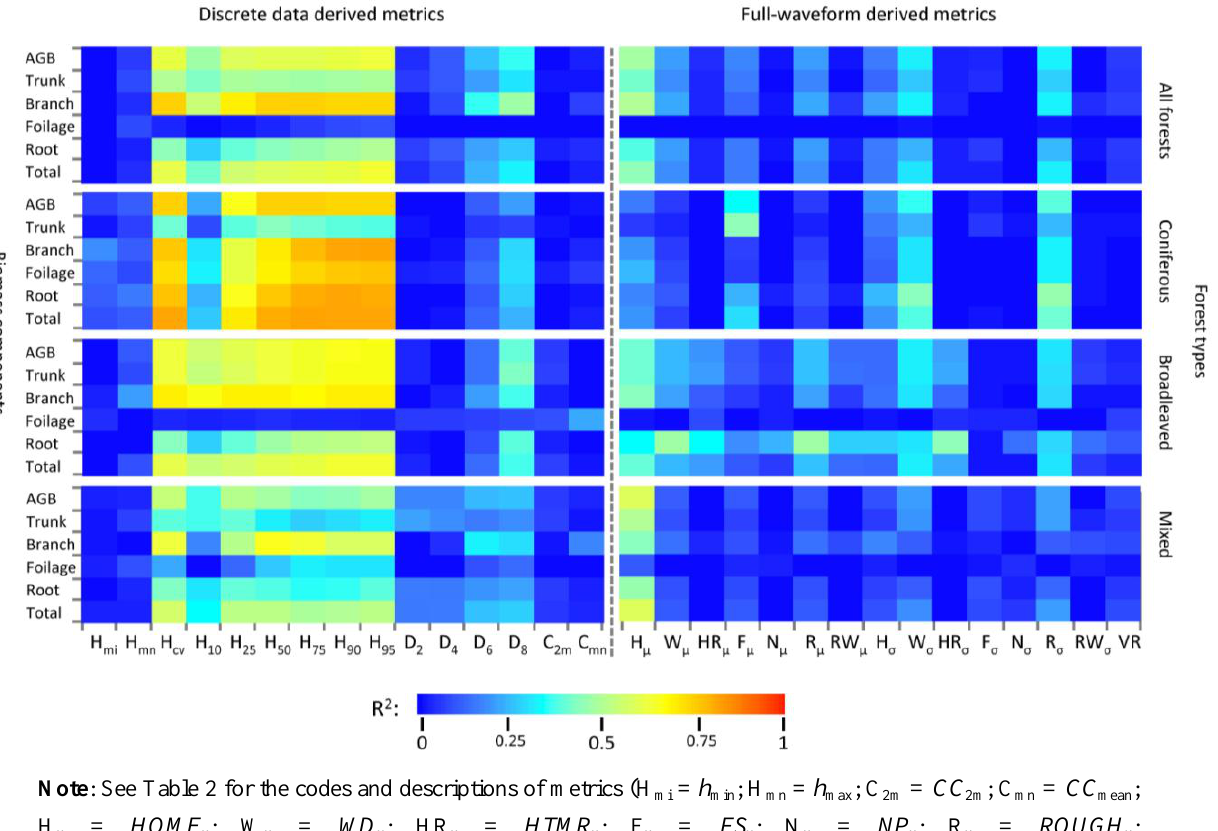
Figure 4. Intensity graph of the square of the Pearson’s correlation coefficient ( R 2 ) between each biomass components and LiDAR-derived metrics. The values of the coefficients are transformed into pixels within a blue-red color